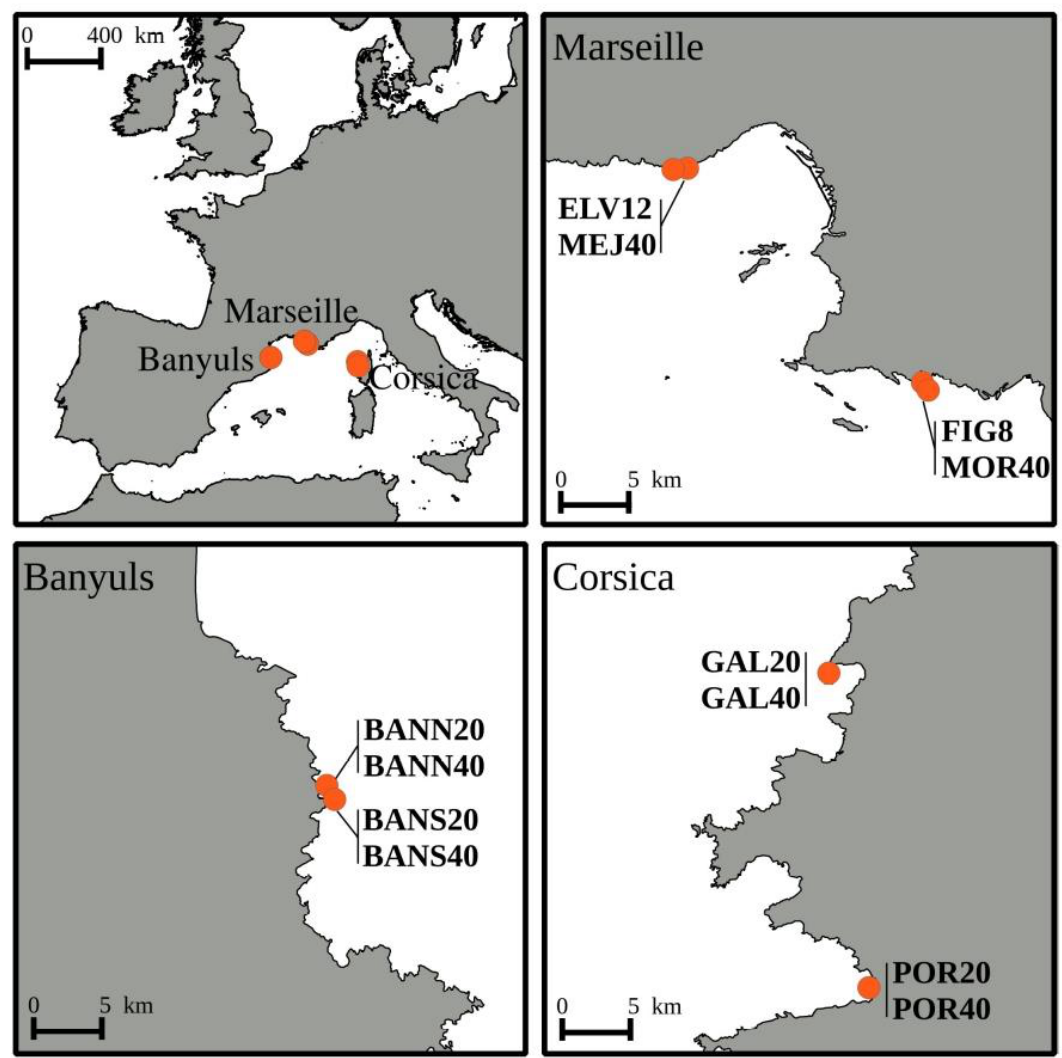
Figure S1. Location of the sampling sites of the red coral among the three studied geographical